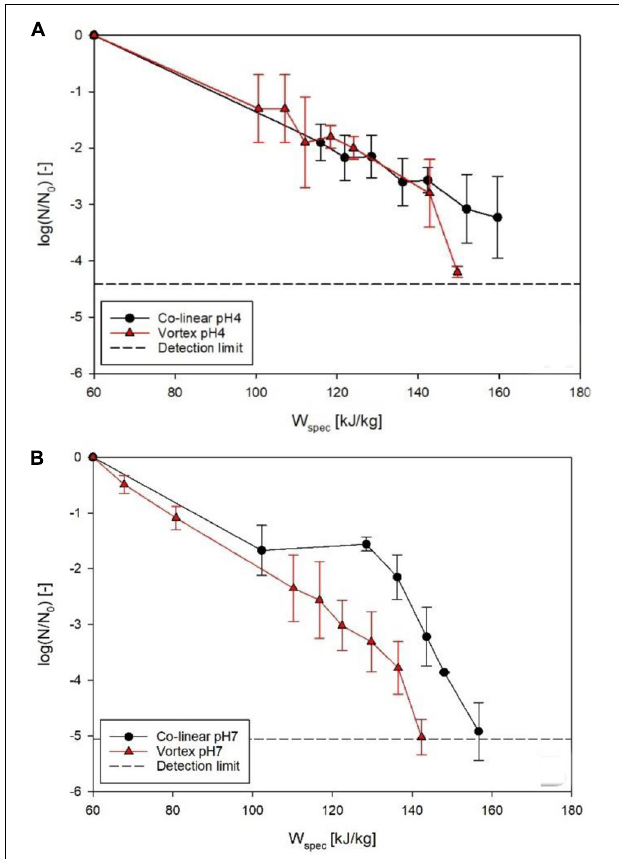
FIGURE 7 | Comparison of M. lacticum inactivation kinetics of co-linear (black circles) and vortex (red triangles) configuration at pH 4 (A) and pH 7 (B) . Data points depict average values, error bars represent the standard